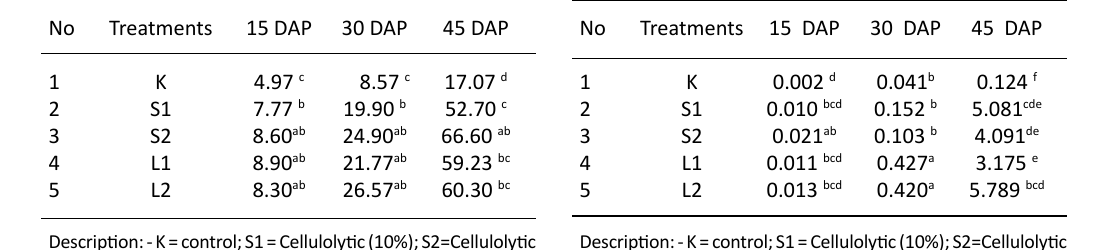
Description: - K = control; S1 = Cellulolytic (10%); S2=Cellulolytic (20%); L1 = Ligninolytic (10%); L2 = Ligninolytic (20%). Numbers followed by different letters within columns are signi cantly different at P < 0.05.